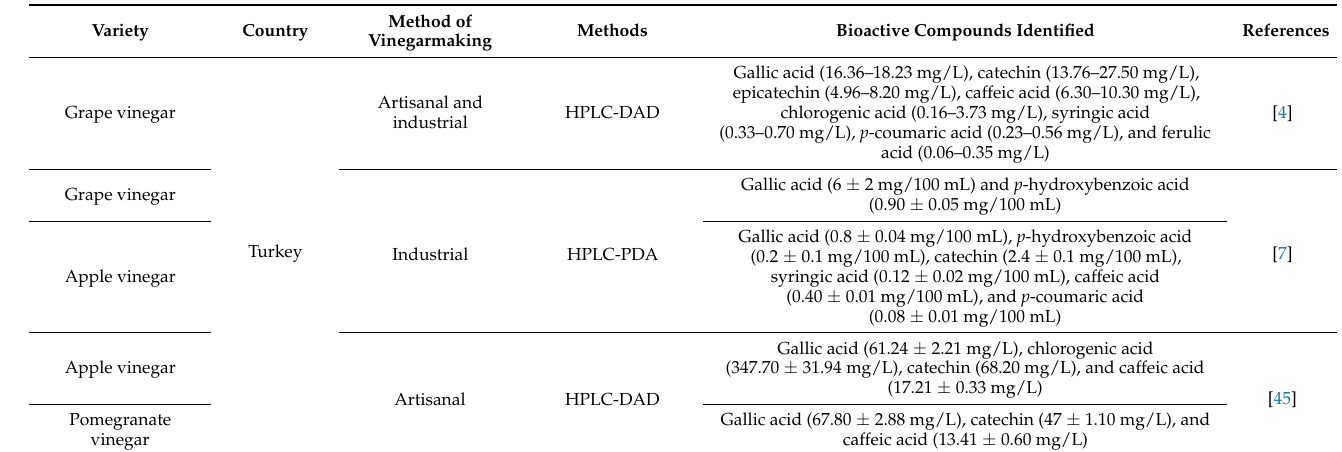
Table 2. Phytochemical profile of fruits